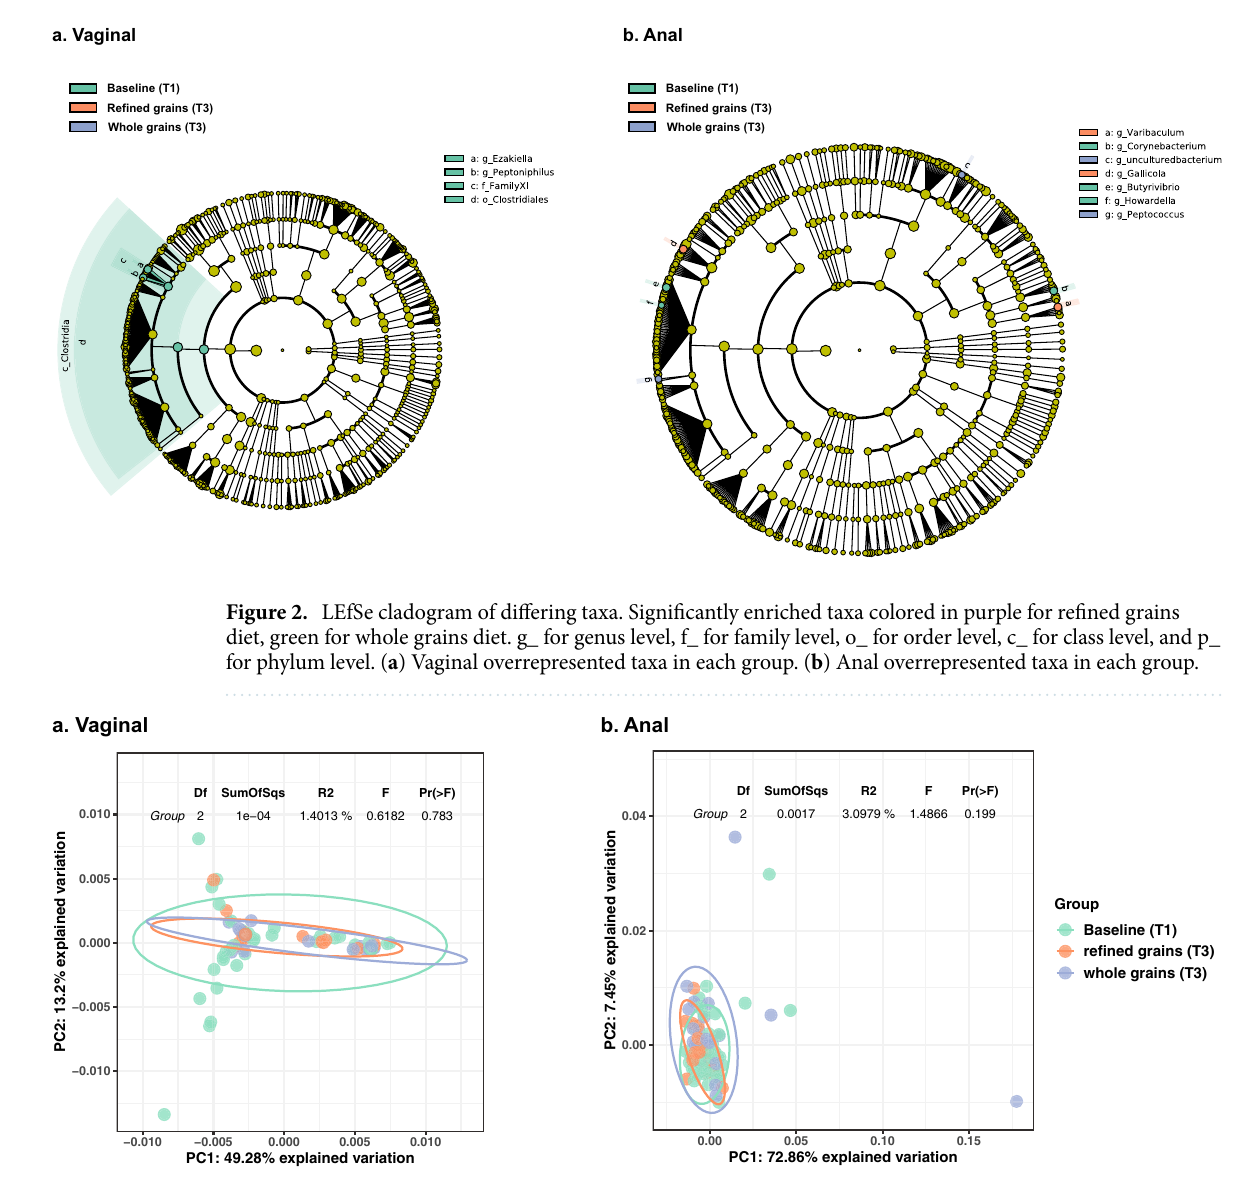
Figure 3. Vaginal and anal microbiome beta diversity. PCoA generated on weighted Unifrac distance. ( a ) Vaginal, ( b ) anal. Table shows the PERMANOVA result effect between baseline, whole grains T3, and refined grains T3. Ellipses represent 95% CI of center of each group under multivariate